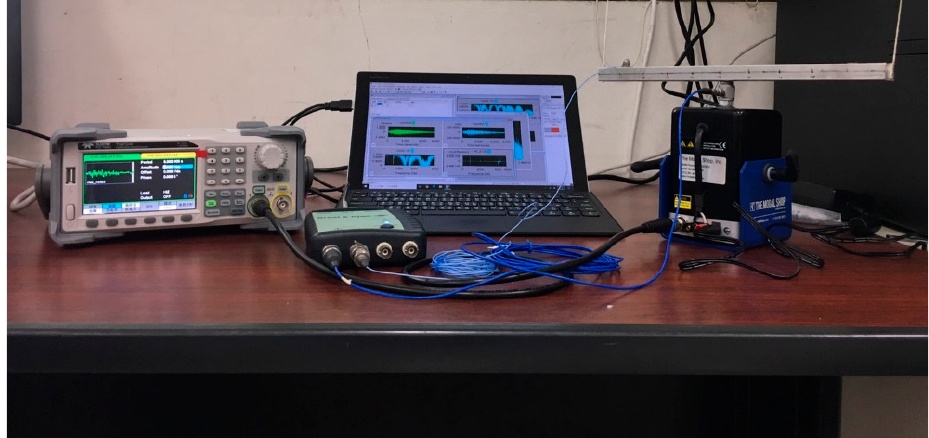
Figure 16. Schematic diagram of the experimental setup.